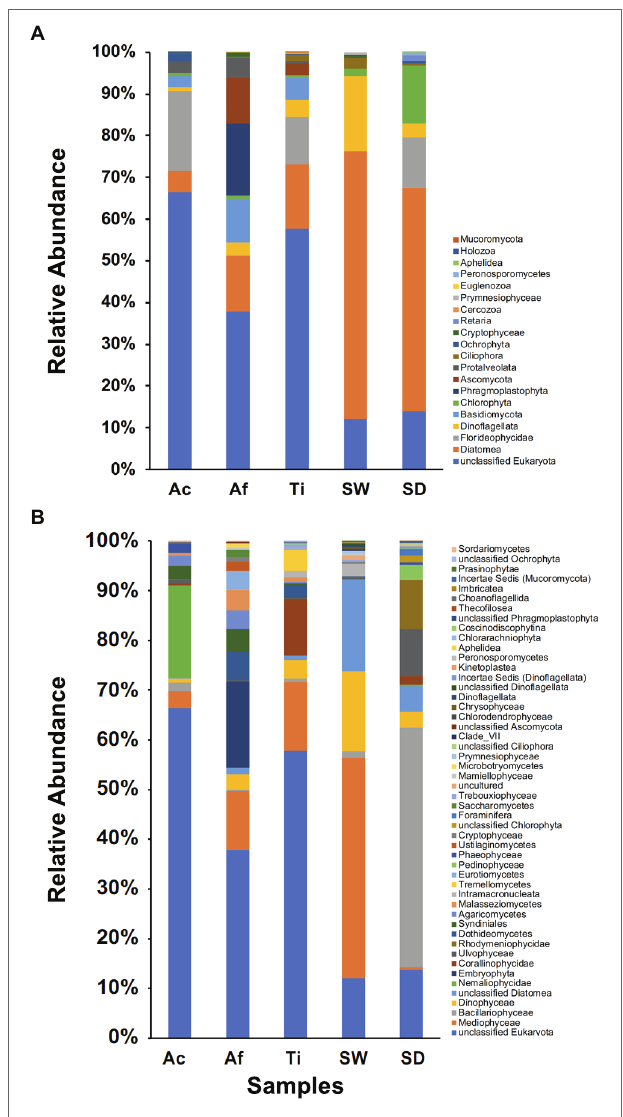
FIGURE 7 | Unicellular eukaryotic community composition for Ac ( Aplysina caissara ), Af ( Aplysina fulva ), Ti ( Tedania ignis ), SW (seawater), and SD (sediment) are shown for 20 phyla (A) and for 50 classes (B)